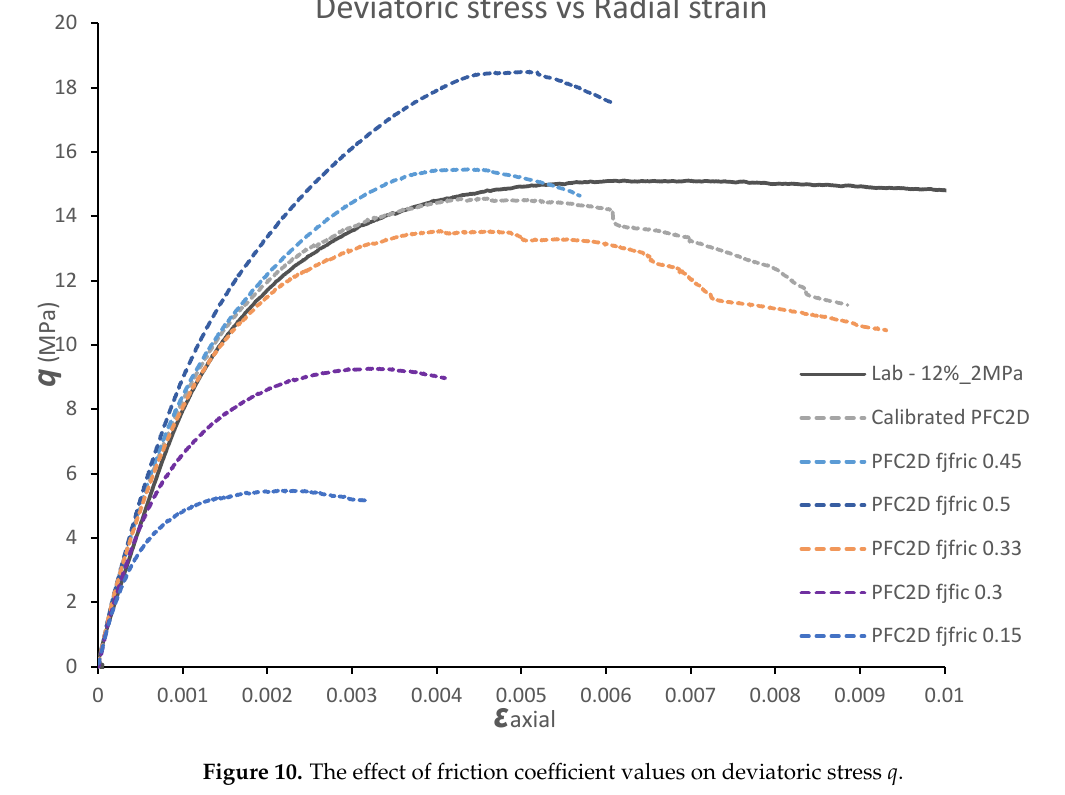
Figure 10. The effect of friction coefficient values on deviatoric stress q.